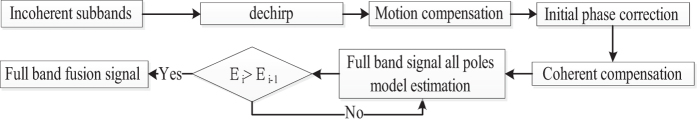
Multiband iterative fusion flow chart.